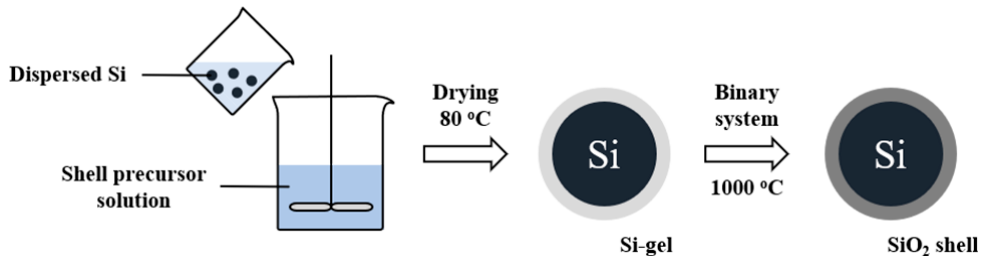
Figure 1. Schematic diagram of the encapsulation process for healing agents.